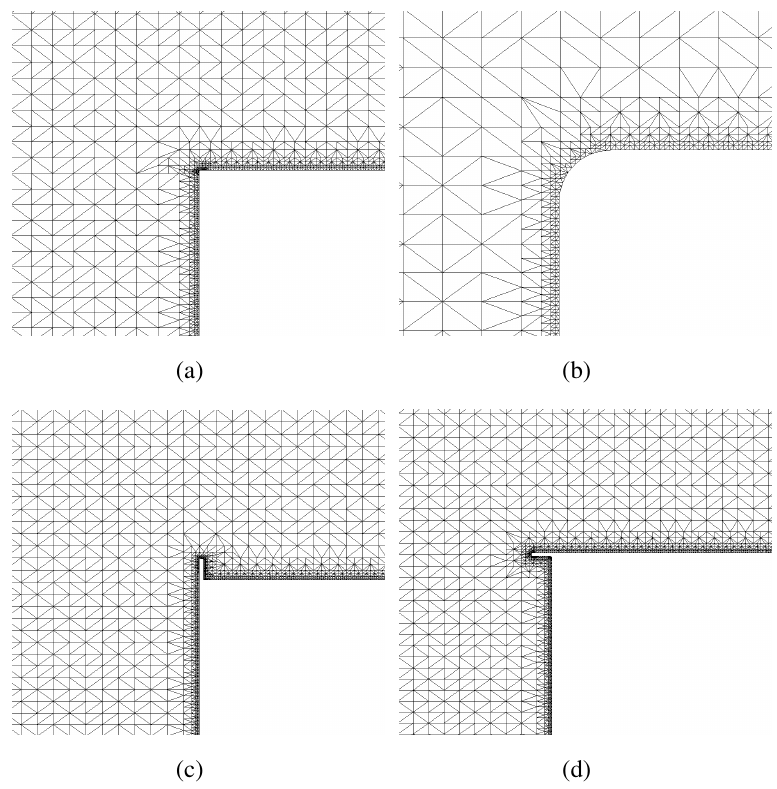
Figure 16. Vertical section detail of the refined meshes obtained using snappyHexMesh for the different roof edge shapes investigated. ( a ) Simple edge, 6.7 M cells ( y + ≈ 325 ); ( b ) curved edge, 6.7 M cells ( y + ≈ 329 ); ( c ) railing, 6.9 M cells ( y + ≈ 314 ); ( d ) cantilever, 6.9 M cells ( y + ≈ 297 ).